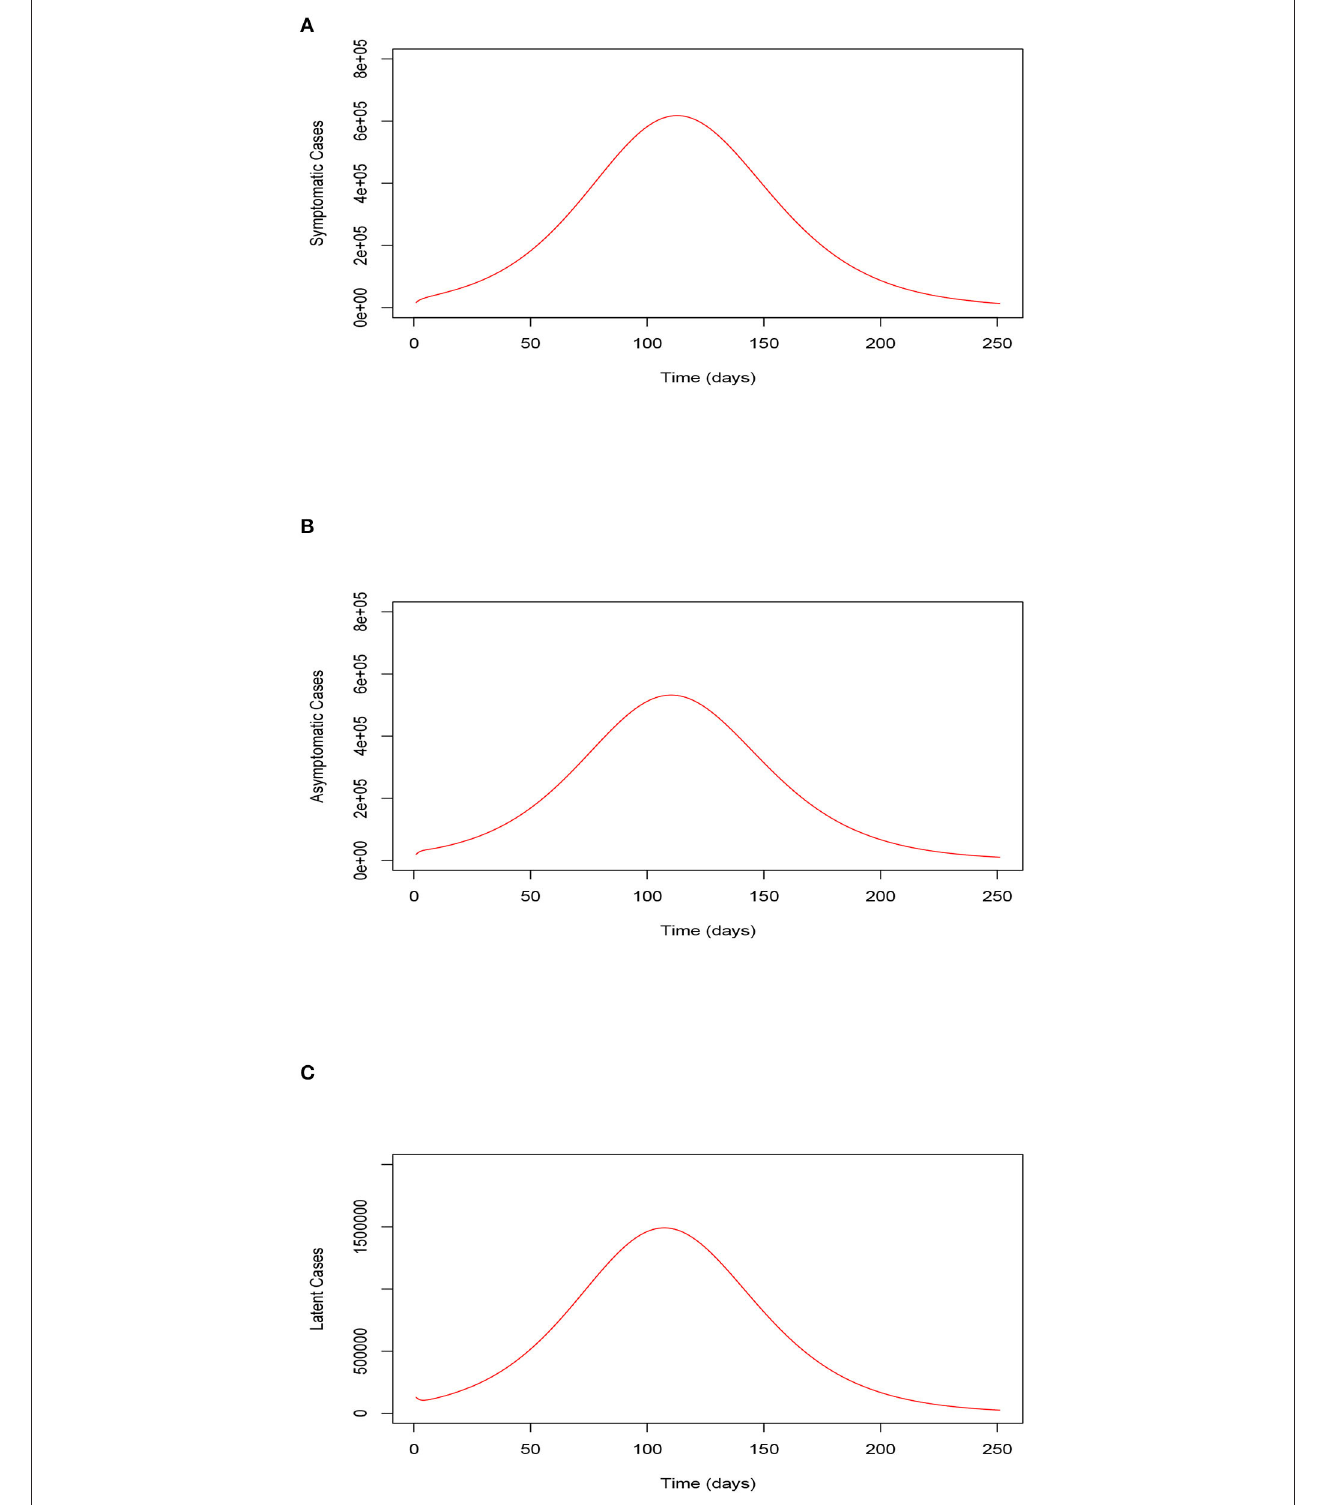
FIGURE 4 | (A) Trajectory of the symptomatic infections for the model (Equations 2–8) when the uptake of the COVID-19 vaccines and the use of face masks by the vaccinated is extremely low. (B) Trajectory of the asymptomatic infections for the model (Equations 2–8) when the uptake of the COVID-19 vaccines and the use of face masks by the vaccinated is extremely low. (C) Trajectory of the latent cases for the model (Equations 2–8) when the uptake of the COVID-19 vaccines and the use of face masks by the vaccinated is extremely low. Trajectory of the symptomatic, asymptomatic, and latent classes of the model (Equations 2–8) when the uptake of the COVID-19 vaccines and the wearing of face masks by the vaccinated is extremely low.